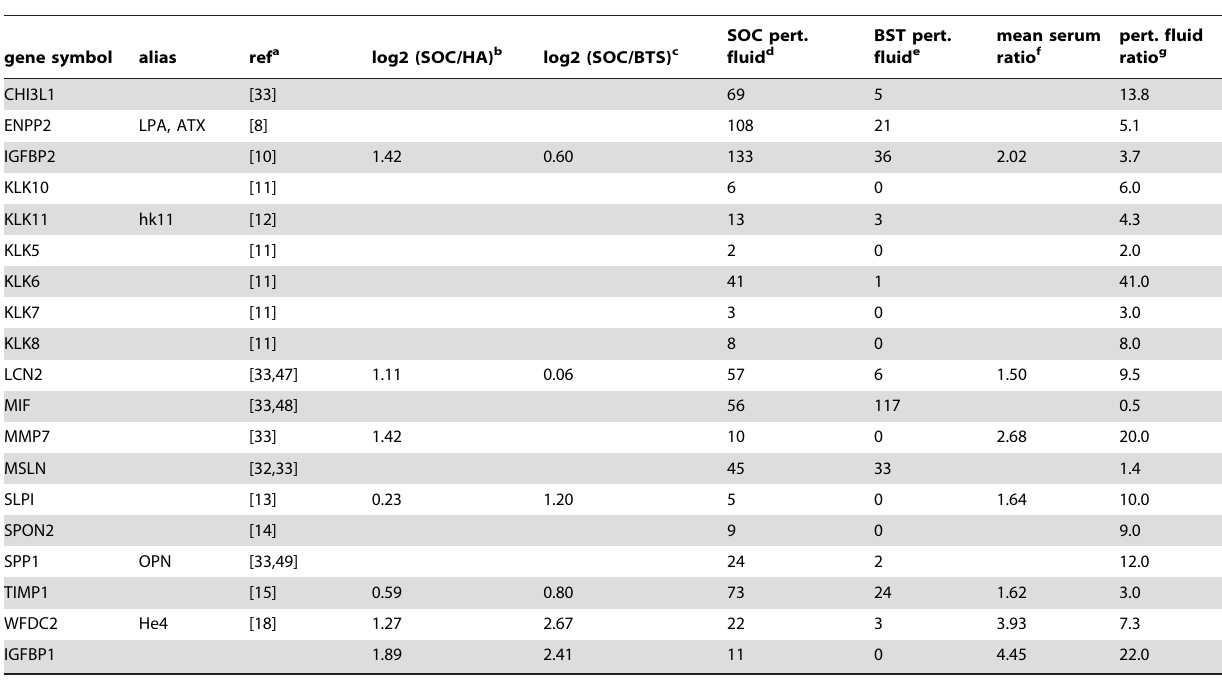
Table 1. Summary of performance of true positive ‘‘benchmark serum proteins.